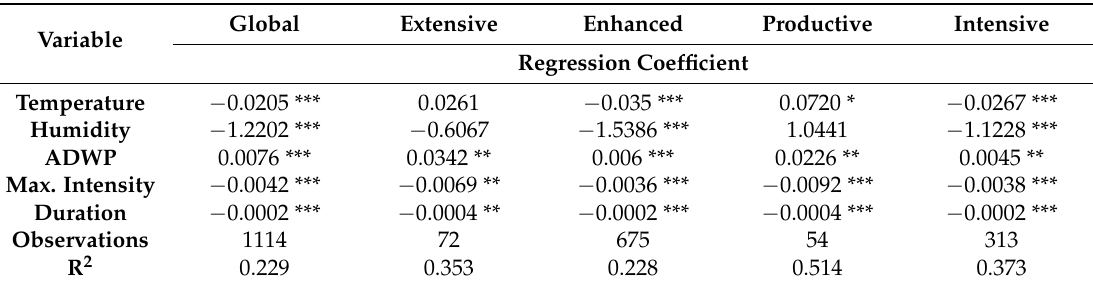
Table 1. Multiple linear regressions for runoff retention rate filtering data by type of substrate. ADWP: antecedent dry weather